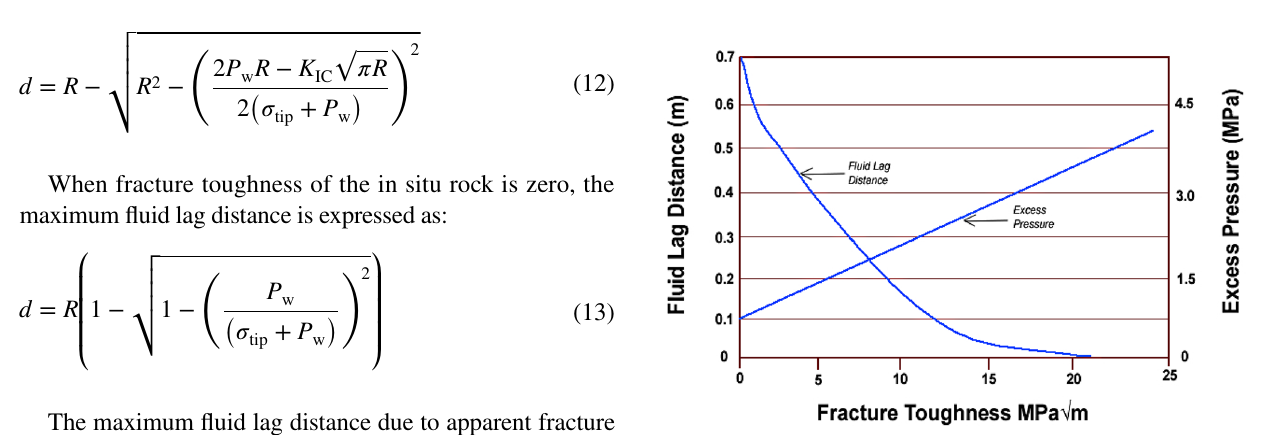
Fig. 5 Variation of fluid lag distance and effective pressure with frac- ture toughness for a typical pre-frac test. Modified after Jeffrey (1989) and McLennan and Potocki